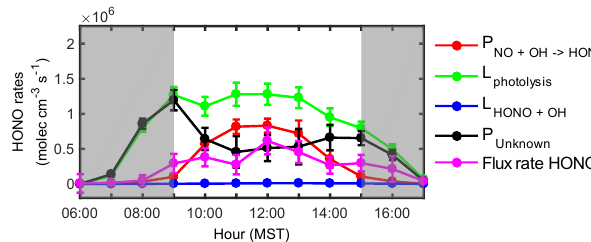
Figure 8. Sunny days hourly average HONO reaction rates. HONO production from OH + NO (red line, Eq. 16), HONO photolysis (green line, Eq. 17), HONO oxidation by OH (blue line, Eq. 18), P unknown (black line, Eq. 19), and HONO flux rate (magenta line). Grey boxes show the morning and evening time range when the pseudo-steady-state assumption was not valid. Error bars show the 1 σ uncertainty of the respective data